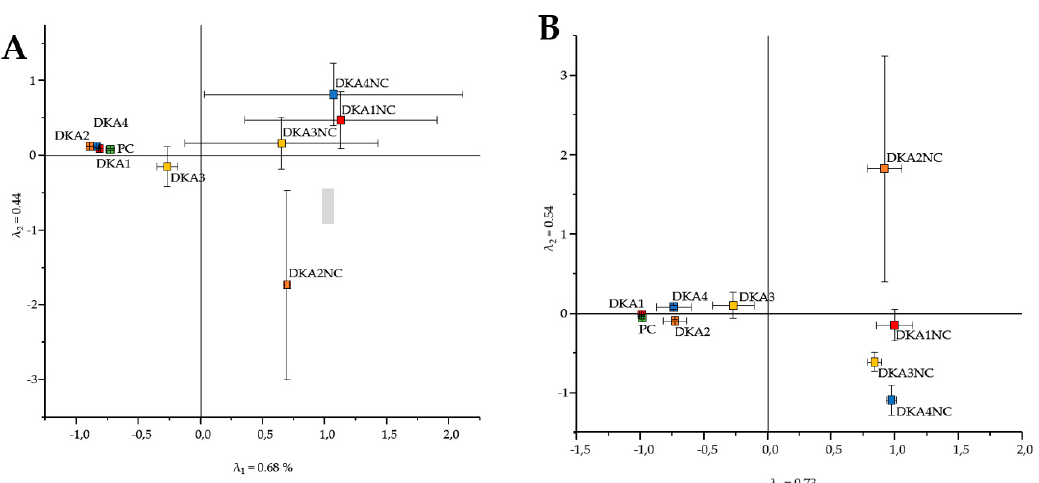
Figure 2. Correspondence analysis of bacterial community compositions for DNA ( A ) and cDNA samples ( B ) of 70% ethanol (DKA1), DNA Away (DKA 2), 5% sodium hypochlorite (DKA 3) and RSDL (DKA 4) decontaminated ticks. PC (positive control) without decontamination and NC (negative control) ticks without contamination. The error bars represent the SD of n = 10 (each treatment, PC) or n = 3 (NC). The details of treatments and replicates are summarized in Table